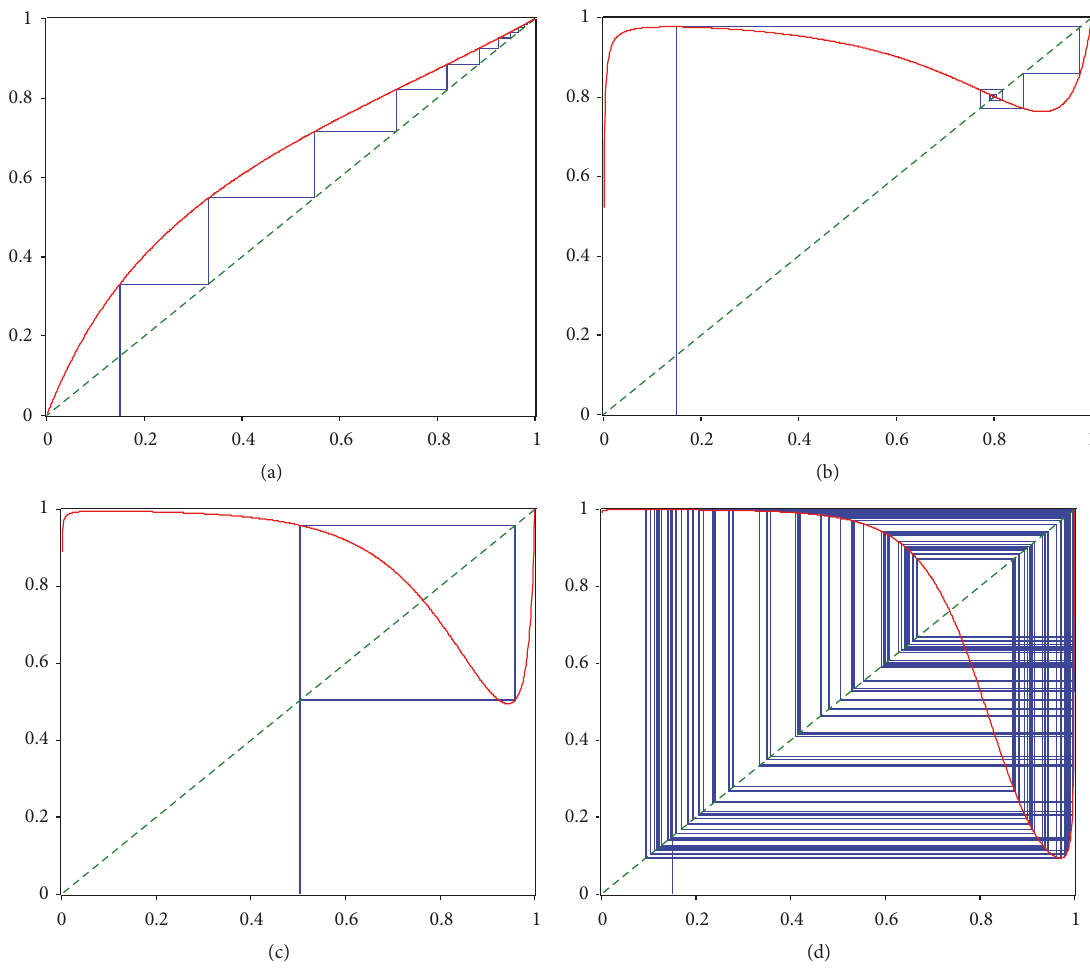
Figure 4: The graph of 𝑓 for 𝑤 𝑥 = 1.5 , 𝑤 𝑦 = 1 , and Δ = 0.1 , 𝑎(0) = 0.15 in (a), Δ = 0.3 , 𝑎(0) = 0.15 in (b), Δ = 0.34 , 𝑎(0) = 0.505 in (c) and Δ = 0.38 , 𝑎(0) = 0.15 in (d), respectively.